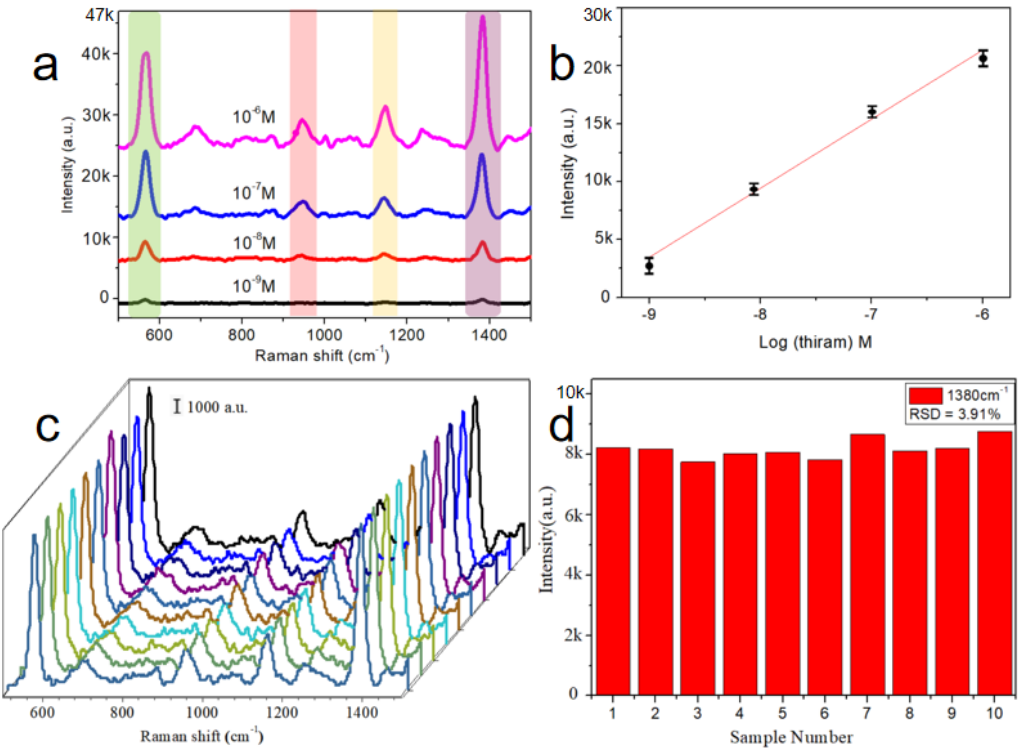
Figure 6. ( a ) SERS spectra for thiram detection with different concentrations; ( b ) relationship between the peak intensity 1380 cm − 1 of the thiram and the logarithmic concentration; ( c ) SERS spectra from 10 randomly selected points; ( d ) SERS intensity distribution of the thiram peak 1380 cm − 1 from 10 randomly selected points.